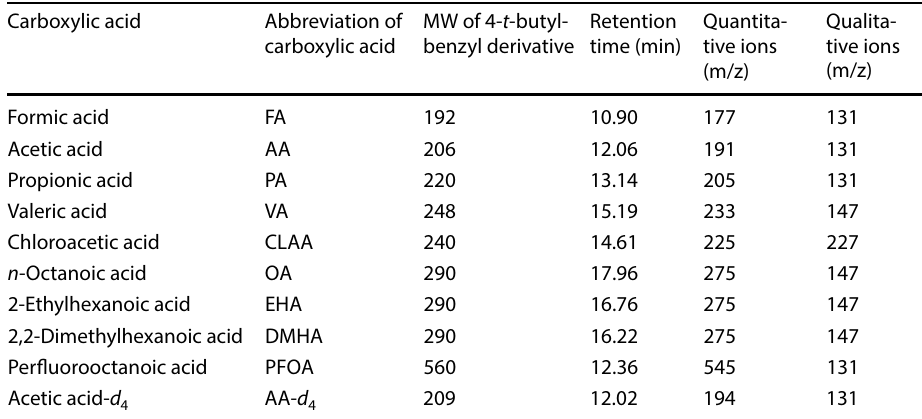
Table 1 Analytical data for 4- t -butylbenzyl